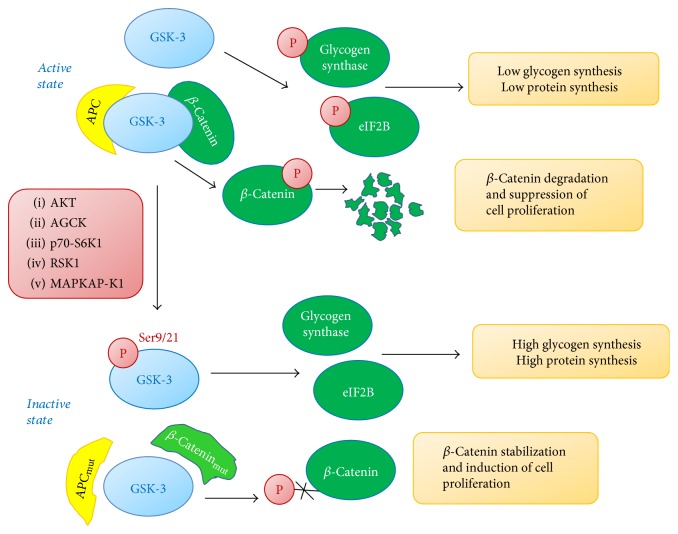
GSK-3 regulation.